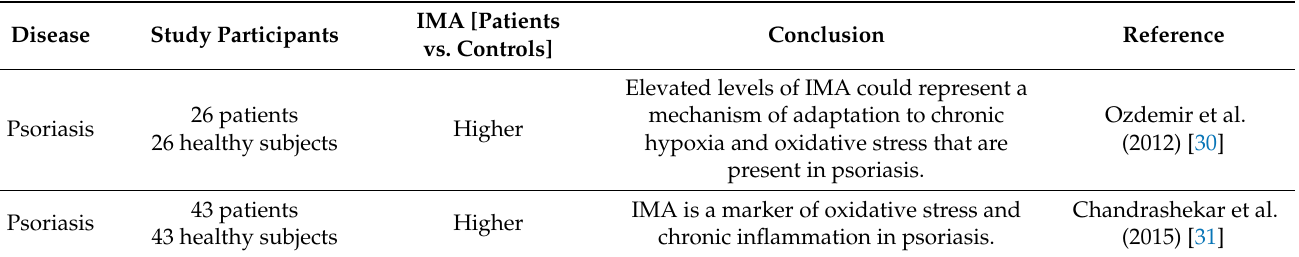
Disease Study Participants